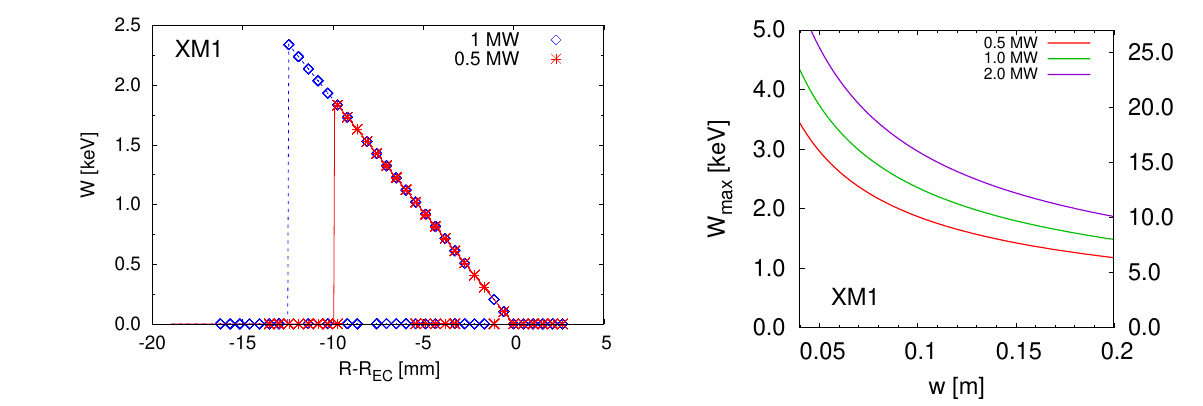
Figure 8. Maximum gained energy (left) and radial width of the interaction region (right) versus local beam width for 170 GHz, XM1 perpendicular propagation and various input power values.